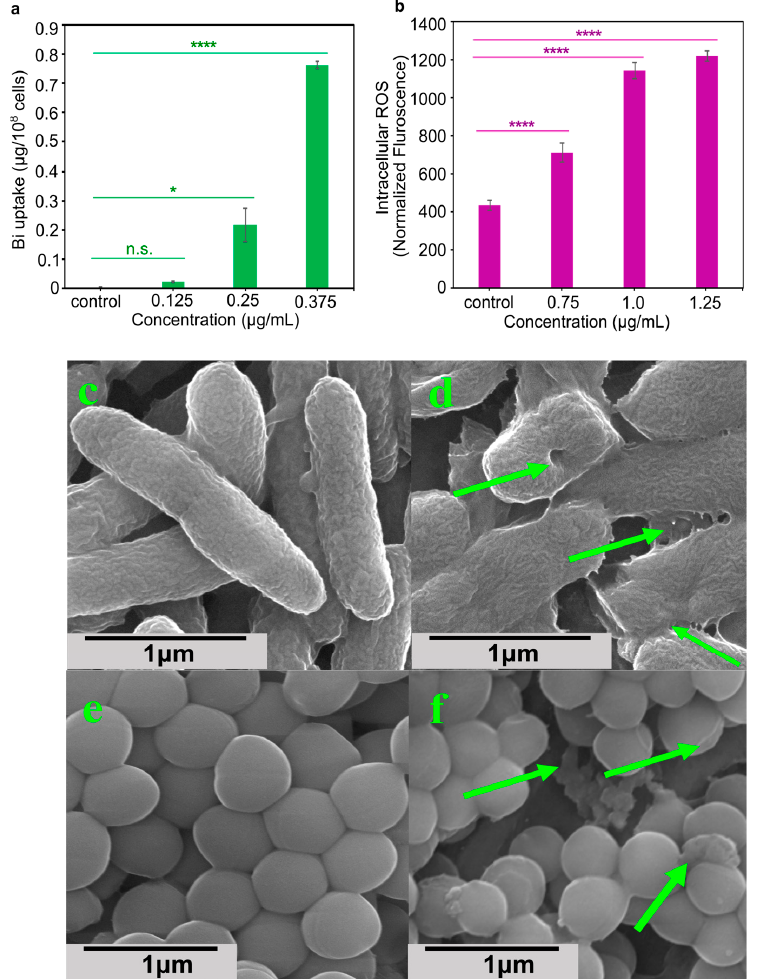
Figure 3. Antimicrobial mechanistic studies of (BiO) 2 CO 3 NPs. ( a ) Cellular uptake of (BiO) 2 CO 3 NPs in DSPA bacteria as measured by Bi concentrations in the cell lysates after 6 h of incubation; ( b ) standardization of ROS production following treatment of DSPA bacterial cells with three doses of (BiO) 2 CO 3 NPs; ( c ) SEM image of the control DSPA cells in comparison with the ( d ) DSPA cells reacted with (BiO) 2 CO 3 NPs; and/or ( e ) SEM image of the untreated control SA cells in comparison